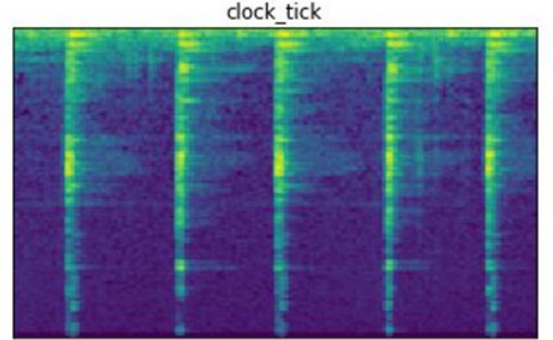
Fig. 7. Clock TIck Spectrogram.